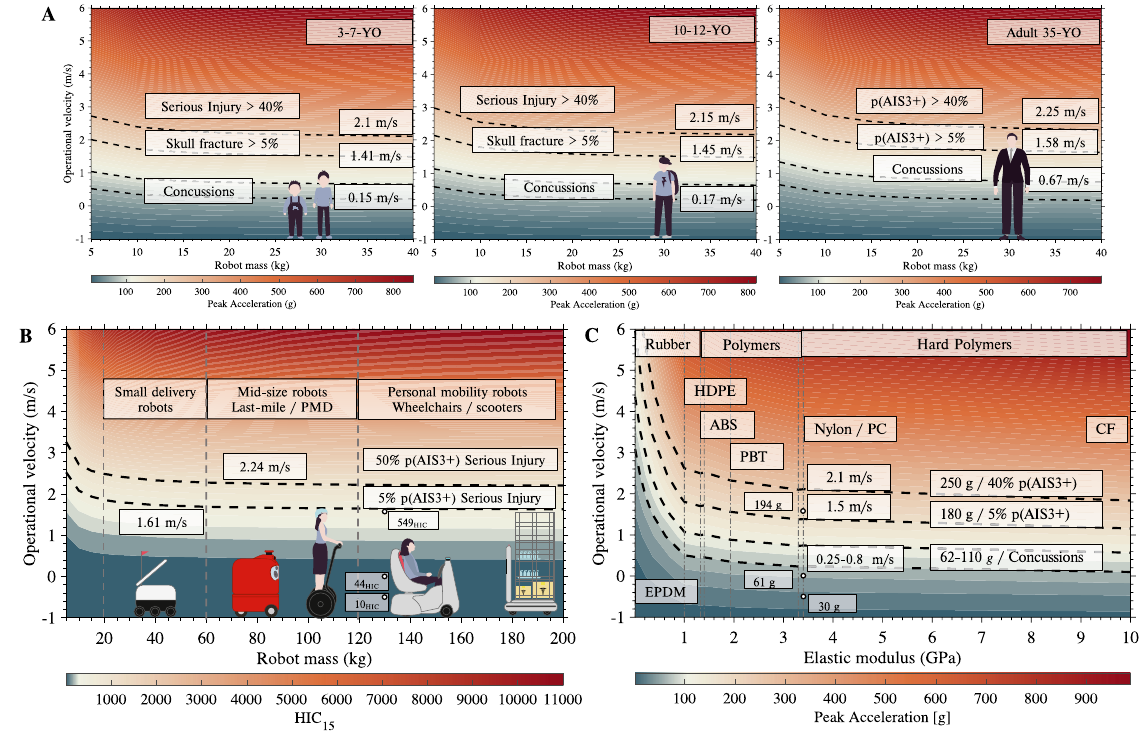
Figure 6. Analysis of design and operational conditions for mobile robots. ( A ) Evaluating the robot design parameters according to possible injury levels in cases of head impact comparing three groups of pedestrians. The reference values of operational velocities account for a pedestrian at 1.5 m/s (5.4 km/h/3.3 mph). Here concussions and serious injuries at 5% and 40% levels are marked by black lines. ( B ) Operational mass